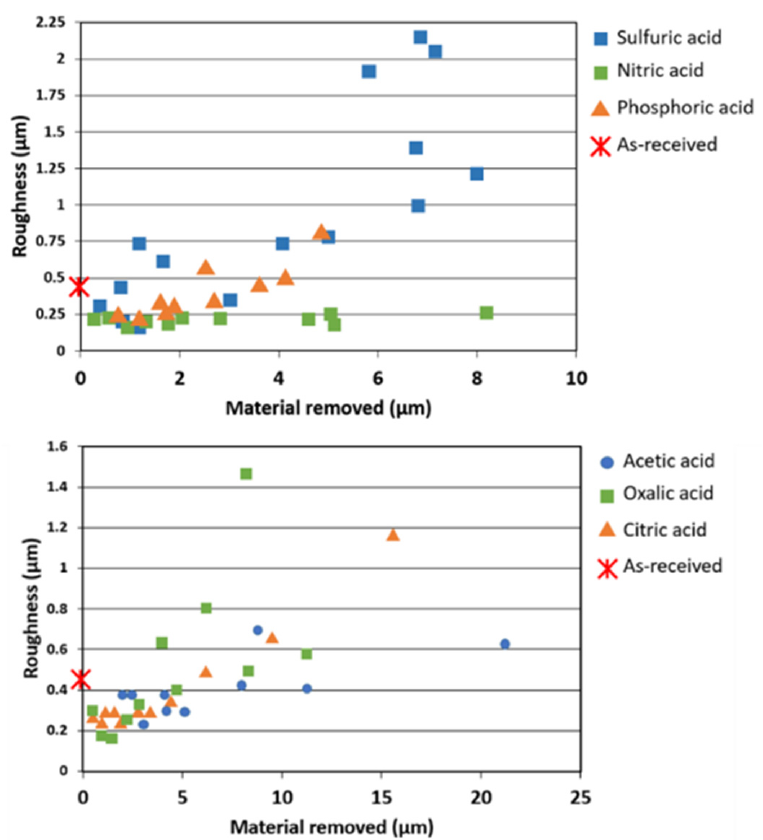
Figure 4 . Variation in the surface roughness with material removed for different inorganic ( top ) and organic ( bottom ) pickling solutions [61,62]. Reprinted from [61,62] with permission from